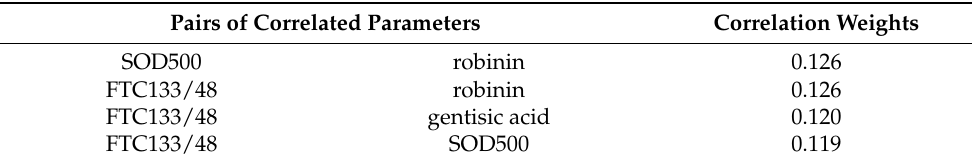
Table 2. Correlation weights for the pairs of parameters based on PCA model. Pairs of Correlated Parameters Correlation Weights SOD500 robinin 0.126 FTC133/48 robinin 0.126 FTC133/48 gentisic acid 0.120 FTC133/48 SOD500